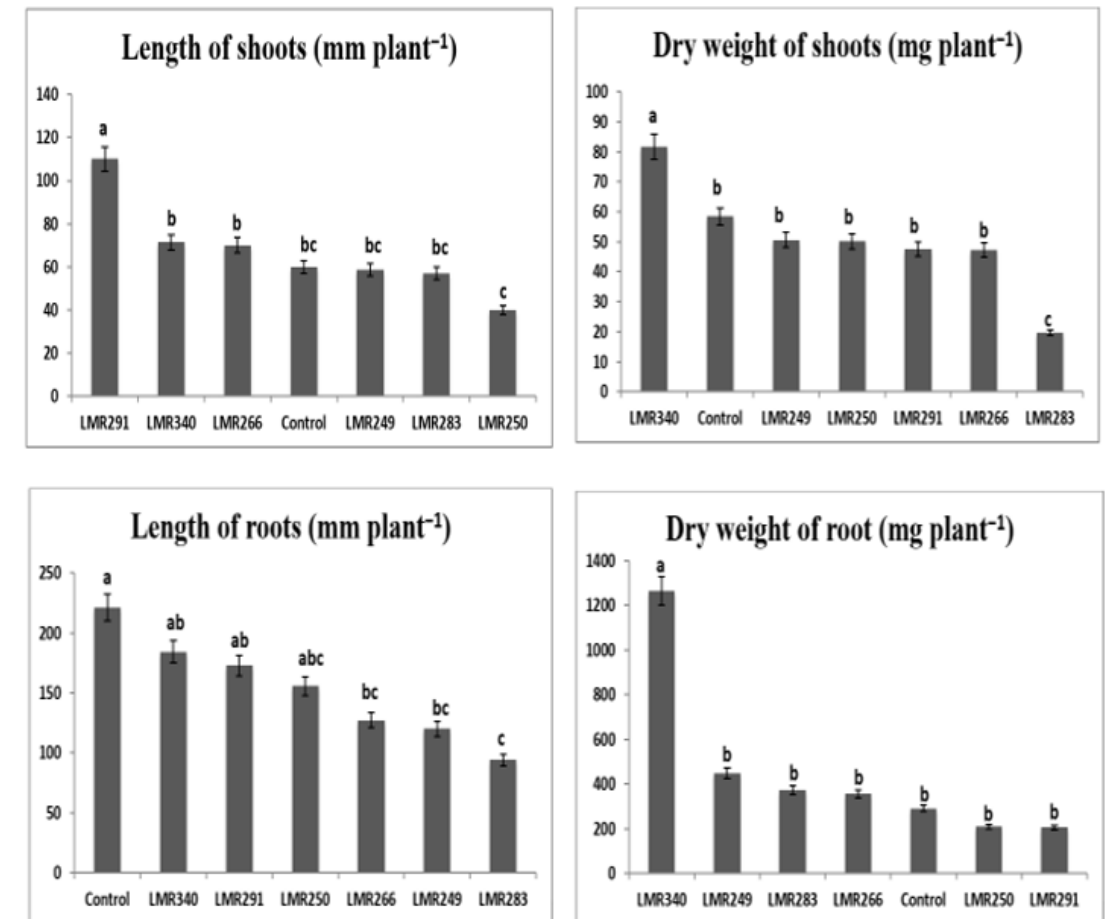
Figure 1. Effect of different bacterial inoculants on growth parameters of Sulla plants grown in sterilized sand. All the values are means of 12 replicates. One-way ANOVA was performed to determine the influence of inoculated bacteria on plant root and shoot biomass. Means for the different treatments with different letters are significantly different from each other ( p < 0.05) according to the Duncan